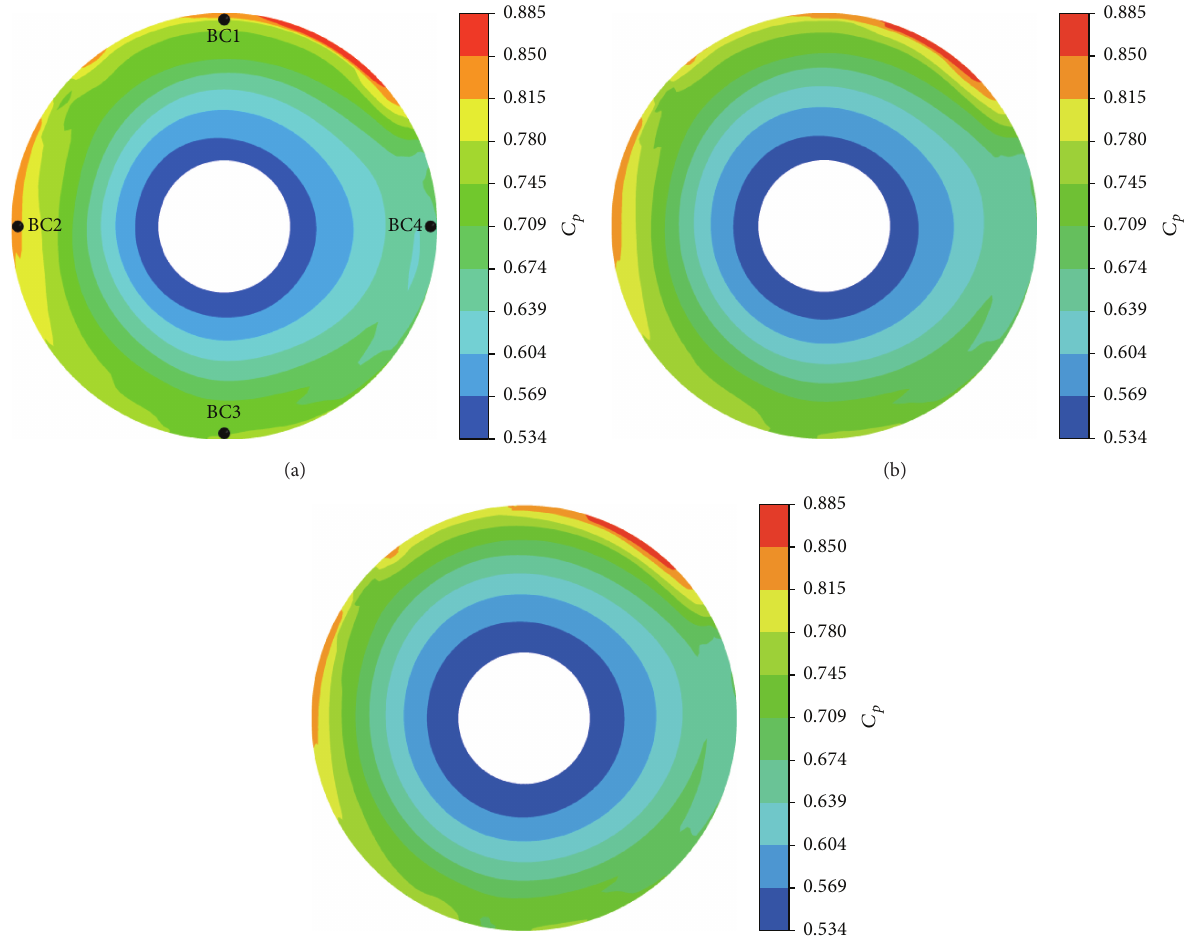
Figure 14: Pressure coefficient distribution on one section of the back sidewall gap at the last timestep: (a) M1, (b) M2, and (c) M3.